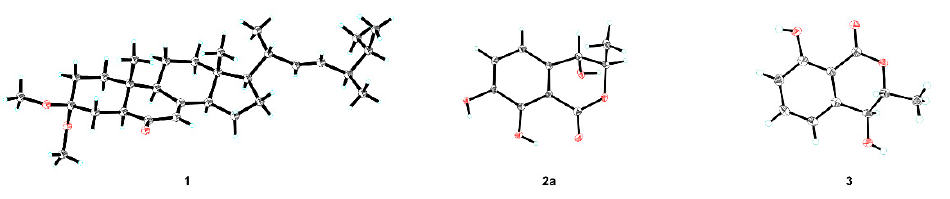
Figure 4. X-ray ORTEP drawing of 1 , 2a , and 3 .